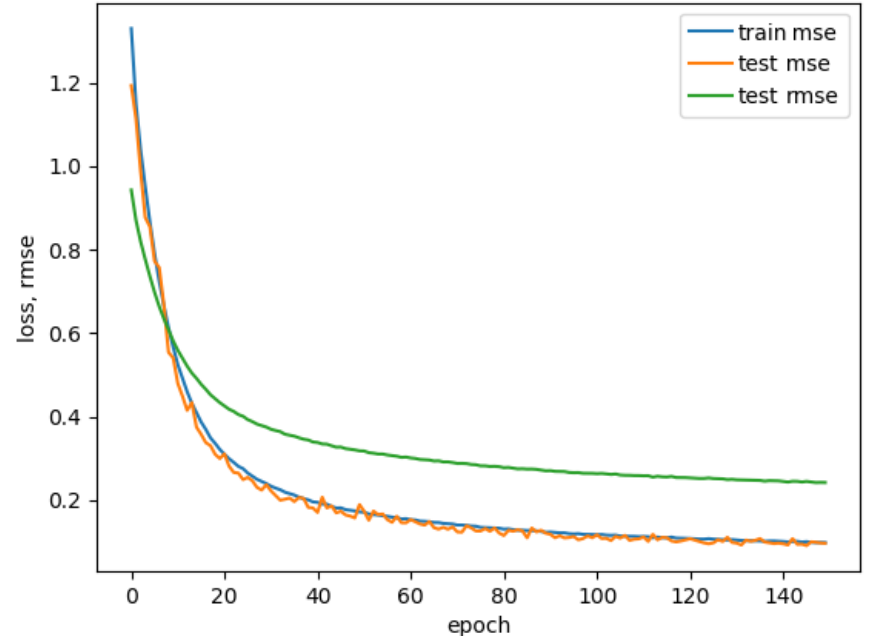
Figure 8. Mean squared error (MSE) on training and testing dataset, and root mean squared error (RMSE) on testing dataset of our neural network model.